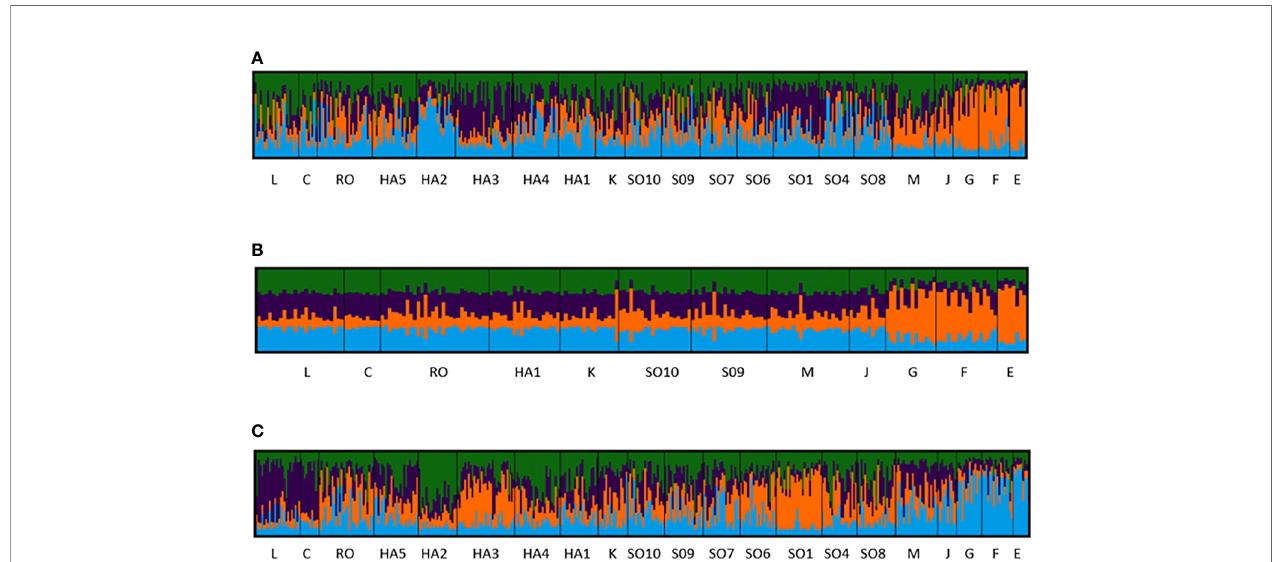
FIGURE 2 | Population structure of Saccharina latissima , based on individual multilocus microsatellite genotypes and an inferred number of genetic clusters of K = 4. Stations are organized from south (L) to north (E) including those in Hardangerfjord (HA) and Sognefjord (SO). Location of the stations is shown in Figure 1 . (A) Analysis with 8 loci and all stations included; (B) Analysis with 8 loci, but only coastal stations included; (C) Analysis with 9 loci (locus SLN35 putatively under positive selection included) and all stations included.